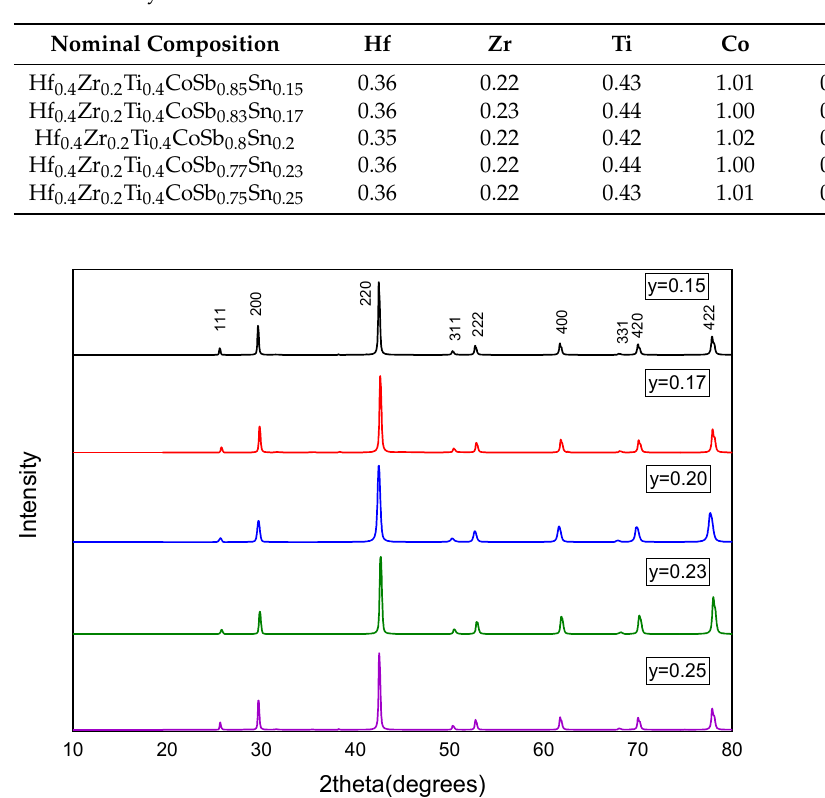
Figure 6. X-ray powder diffraction patterns of Hf 0.4 Zr 0.2 Ti 0.4 CoSb 1-y Sn y (y = 0.15–0.25) hot-pressed pellets. Table 4. The lattice parameter, geometrical density and relative density based on the crystallographic density of the hot-pressed Hf 0 . 4 Zr 0 . 2 Ti 0 . 4 CoSb 1-y Sn y samples.